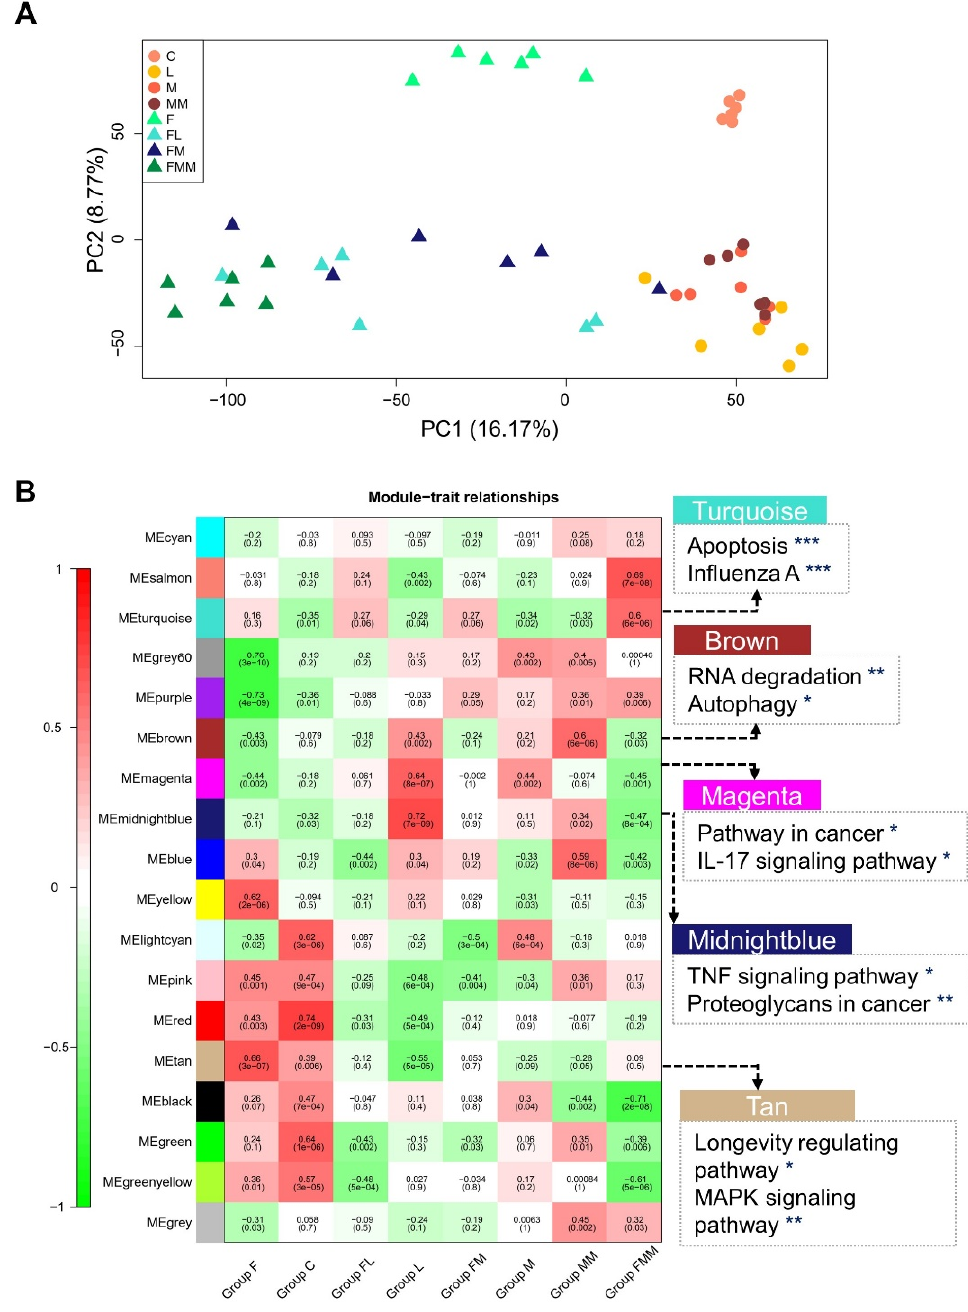
Figure 2. Five key WGCNA modules related to important KEGG pathways of Mac-T cells post FA treatment and bacteria challenge. ( A ) Principal component analysis (PCA) of 48 samples. ( B ) WGCNA analysis reveals the relationships between each module in each row and each treatment in each column. And the value outside the bracket represents the correlation coefficient, the value in the bracket is the p value. (* p < 0.05, ** p < 0.01 and *** p < 0.001). Five key WGCNA modules and partially enriched KEGG pathways are listed on the right side.